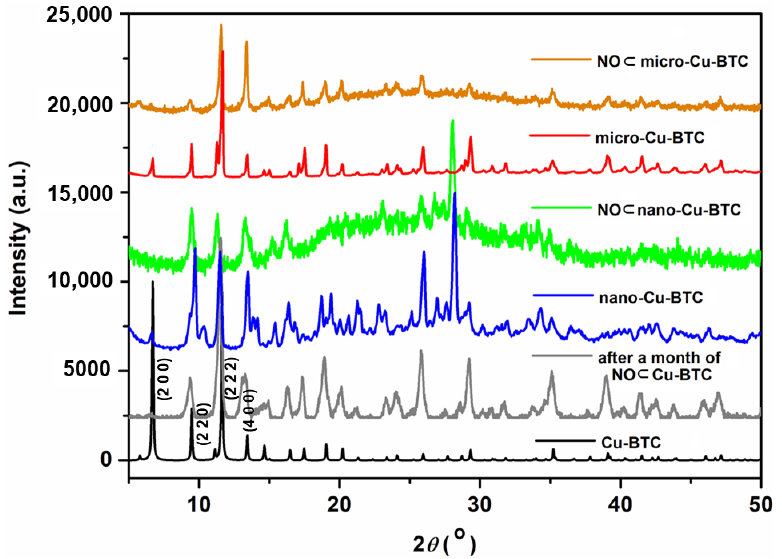
Figure 3. Powder X-ray diffraction (PXRD) of micro-sized Cu-BTC 1 (red) , nano-sized Cu-BTC 2 (blue), NO ⊂ micro-Cu-BTC 3 (yellow), NO ⊂ nano-Cu-BTC 4 (green), and NO ⊂ micro-Cu-BTC 3 after loading NO (grey).